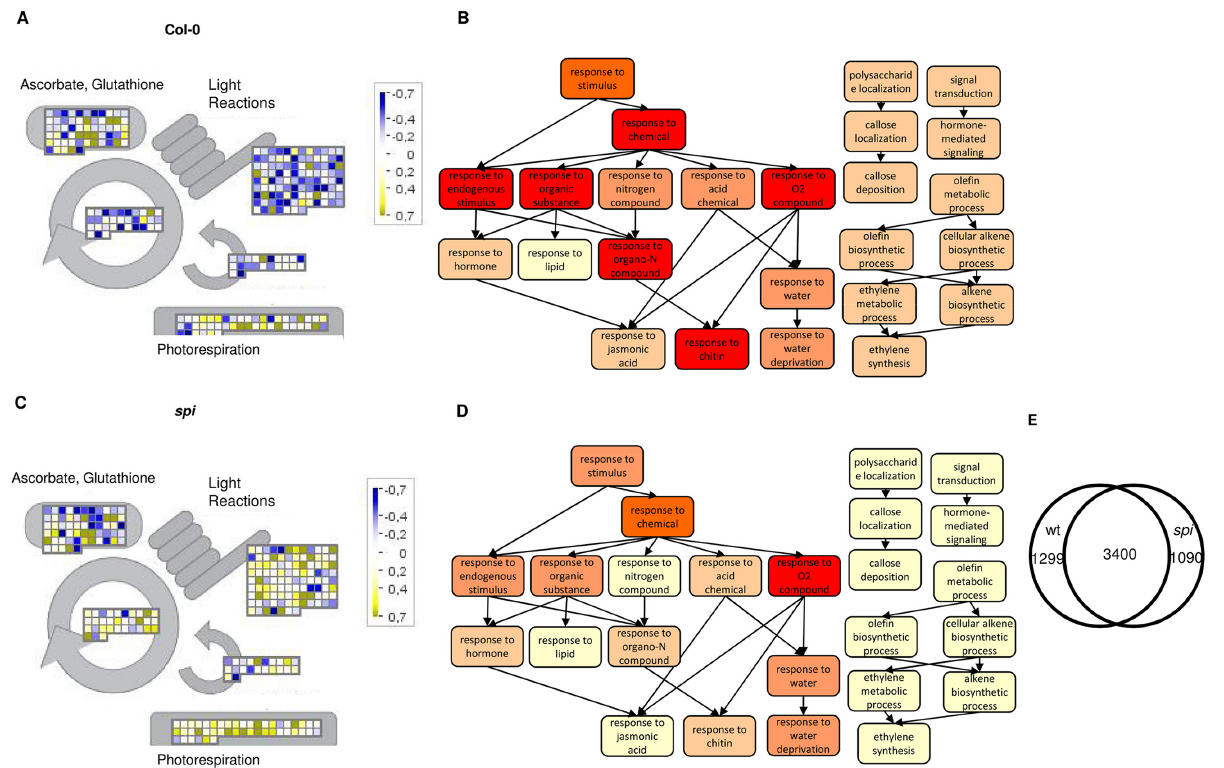
Fig 6. Transcriptome-wide analysis. (A) Mapman visualization of log2-fold changes in Col-0 upon salt treatment and (B) the corresponding 25 most strongly enriched GO terms. Darker colors in GO term categories represent higher q-values (BH-corrected). (C) Mapman visualization of log2-fold changes in spi upon salt stress induction and (D) the corresponding 25 most strongly enriched GO terms in spi . For color codes see 6C. (E) Venn diagram comparing the salt stress-dependent up-regulation of transcripts in Col-0 (wt) and spi (see also S8